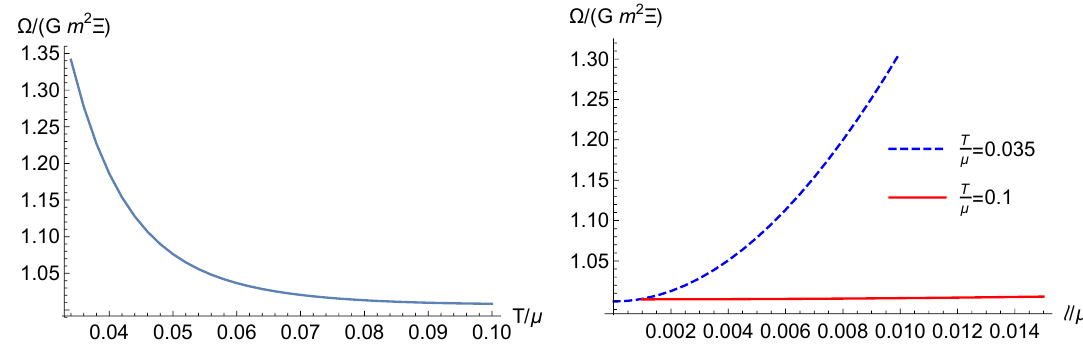
Figure 9 . Left: T=(cid:22) dependence of the ratio (cid:10) = ( m 2 (cid:4)) for ( ‘=(cid:22); k=(cid:22); (cid:21)=(cid:22) ) = (0 : 01 ; 0 : 01 ; 10 (cid:0) 5 ). Right: ‘=(cid:22) dependence of the ratio (cid:10) = ( m 2 (cid:4)) for ( (cid:21)=(cid:22); T=(cid:22); k=(cid:22) ) = (2 (cid:2) 10 (cid:0) 4 ; 0 : 1 ; 0 : 1) (red, solid) and ( (cid:21)=(cid:22); T=(cid:22); k=(cid:22) ) = (10 (cid:0) 5 ; 0 : 035 ; 0 : 01) (blue,